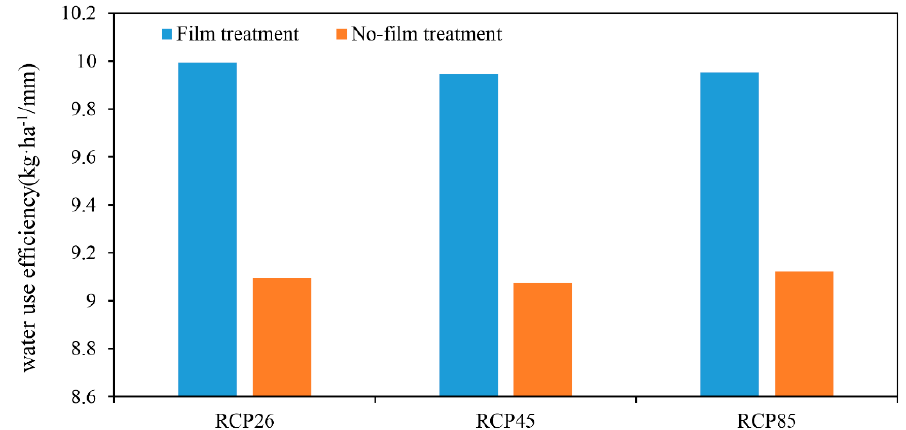
Figure 9. Water use e ffi ciency under three emission pathways for average situations of the three climate scenarios.